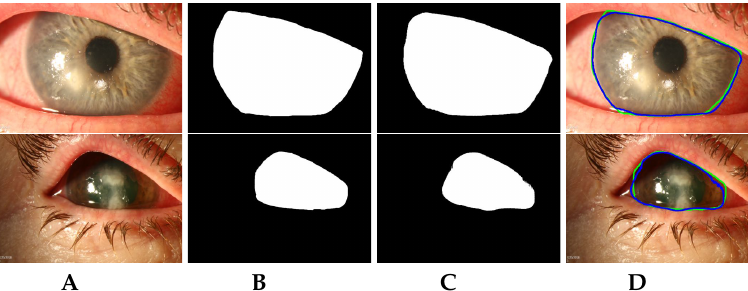
Figure 3. Sample of fully-automatic segmentation results by MS-CNN on diffuse white light images. ( A ) Original images (source: [12]); ( B ) Actual masks obtained for images in ( A ); ( C ) Predicted masks for images in ( A ) using MS-CNN; ( D ) Contour plots of actual (green) and predicted (blue) masks on original images.